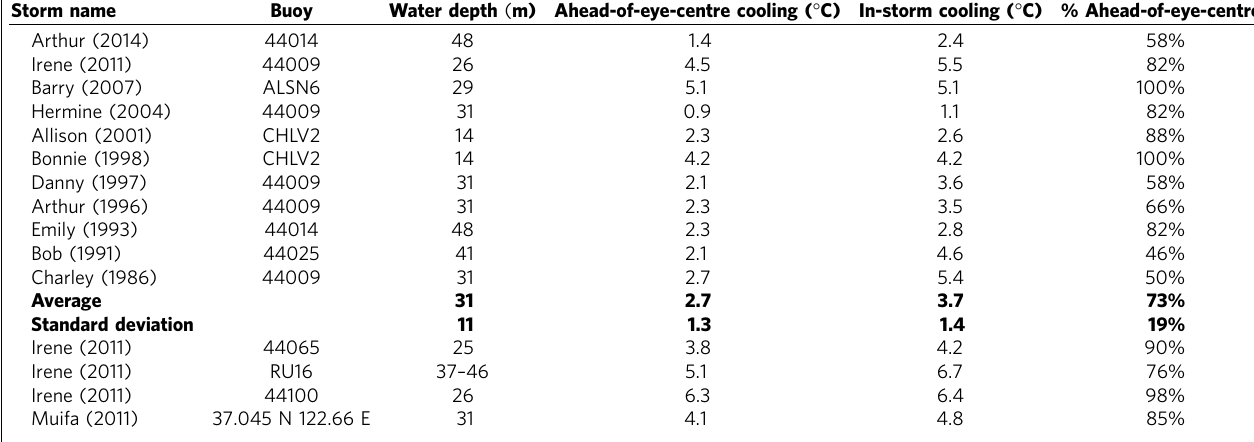
Table 1 | Sea surface temperature cooling in coastal tropical